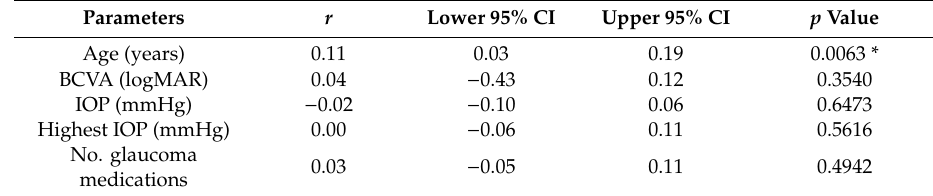
Table 3. Possible associations among advanced glycation end products and various continuous parameters.